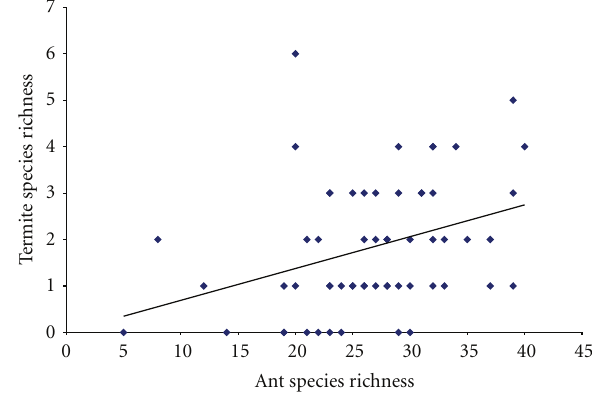
Figure 2: Relationship between the species richness of ground- dwelling ants and termites (Spearman’s Rho = 0.353, P = 0 . 006, n = 60).